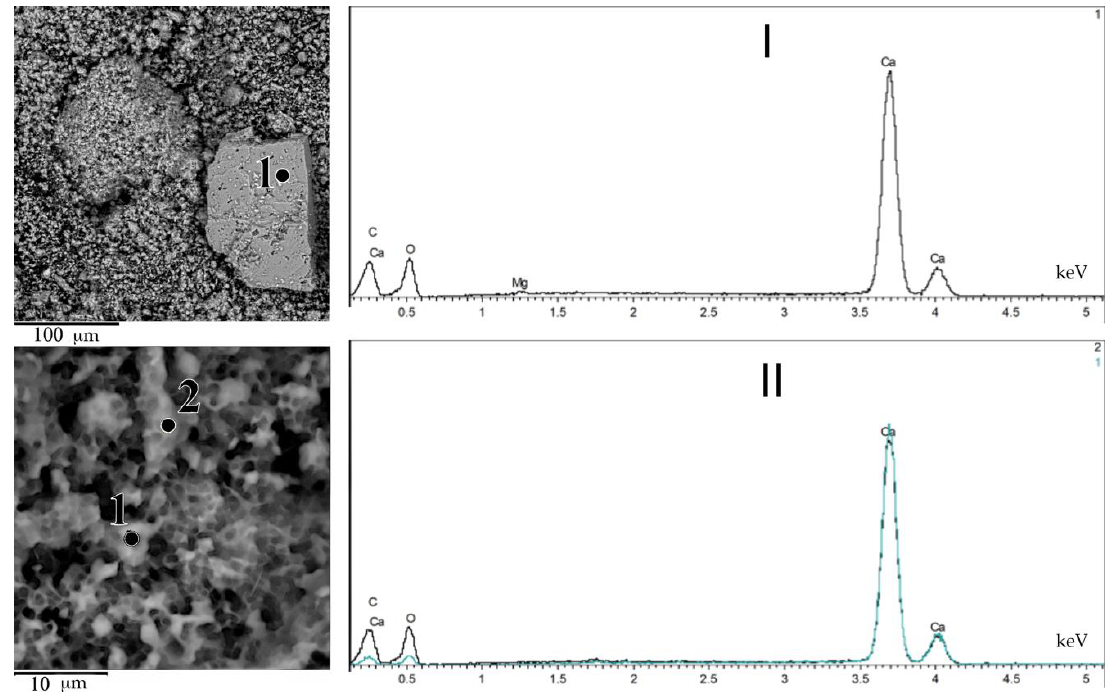
Figure 5. Carbonate masonry material: I —calcite aggregates, which are fragments of building materials; II —aggregates of microcrystalline mass–recrystallization products; energy spectra (EDX) are shown. Sample E-20-KR-ChU-1.